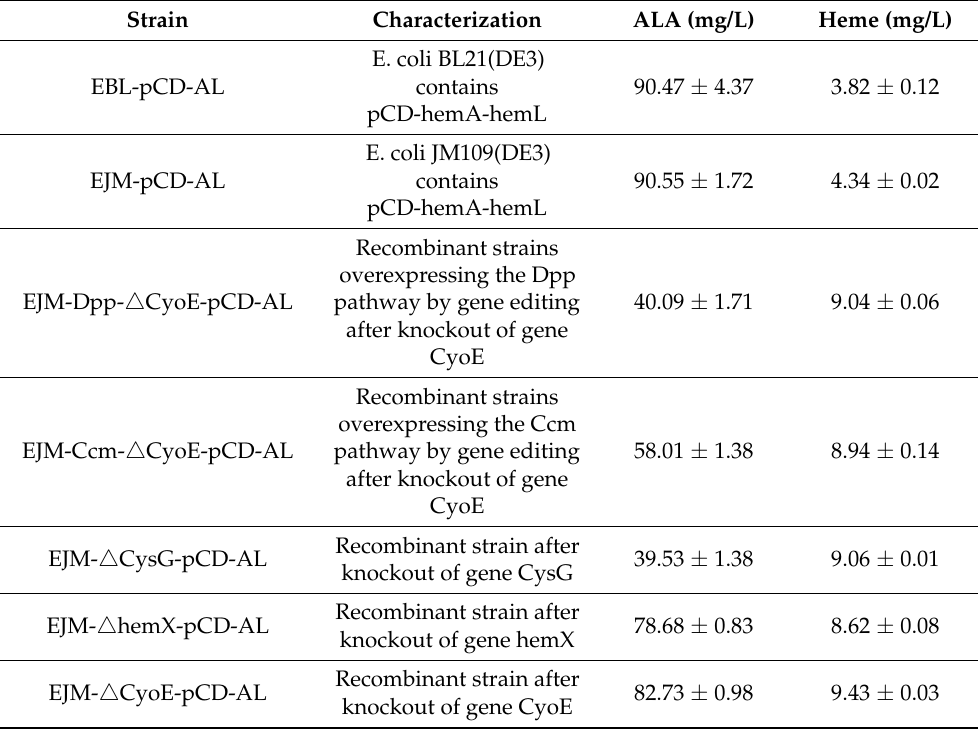
Table 1. This table shows the ALA and heme production detected by fermentation of recombinant strains constructed in this